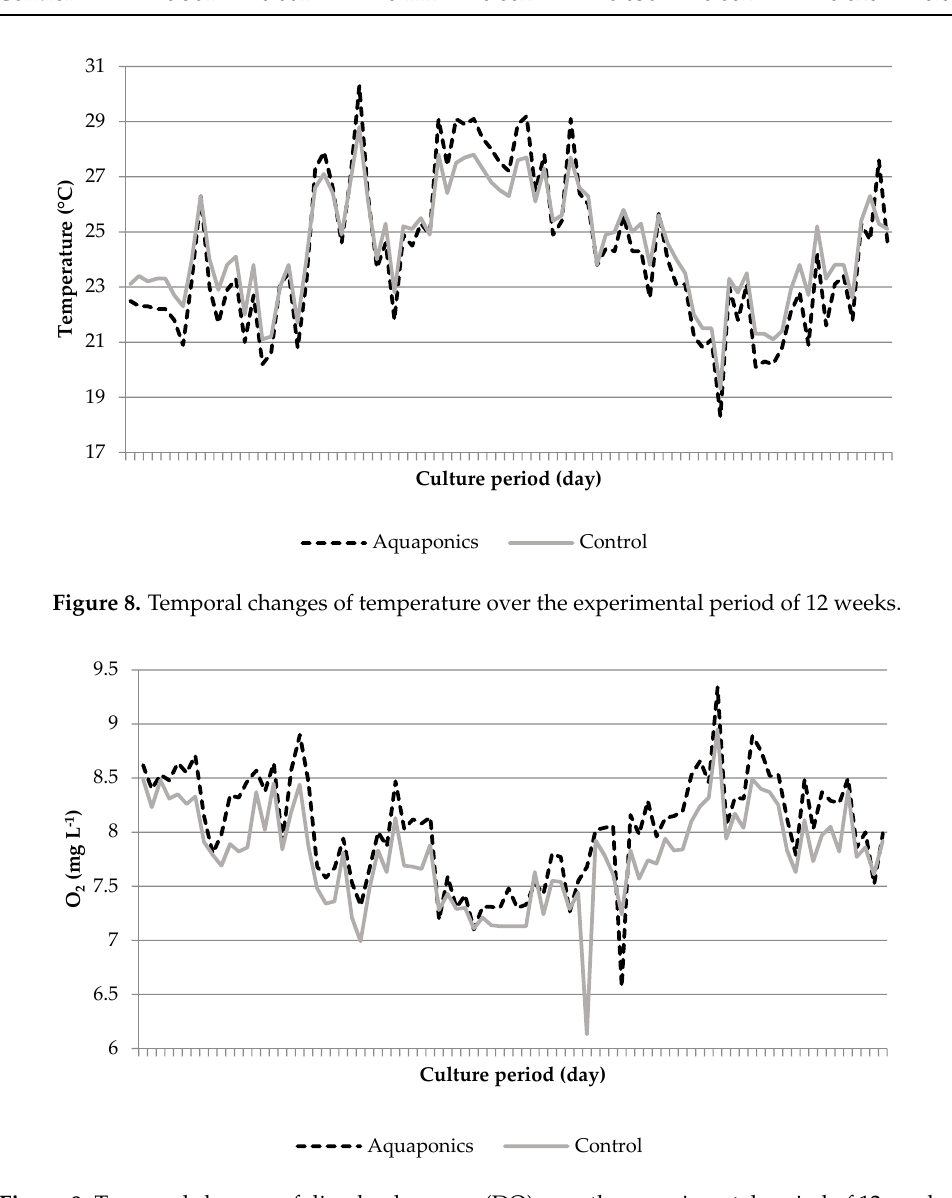
Figure 9. Temporal changes of dissolved oxygen (DO) over the experimental period of 12 weeks.